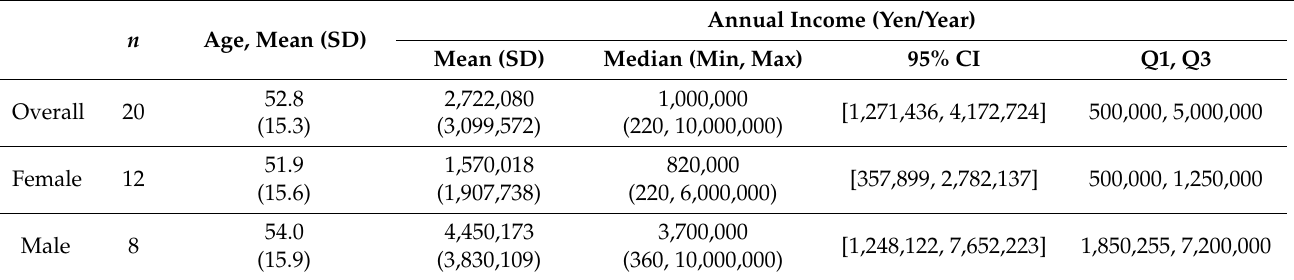
Table 3. The annual income of caregivers of patients with retinitis